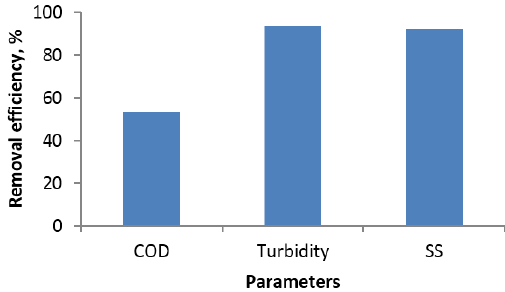
Figure 6. Removal efficiency of the combination of ferric chloride and chitosan.